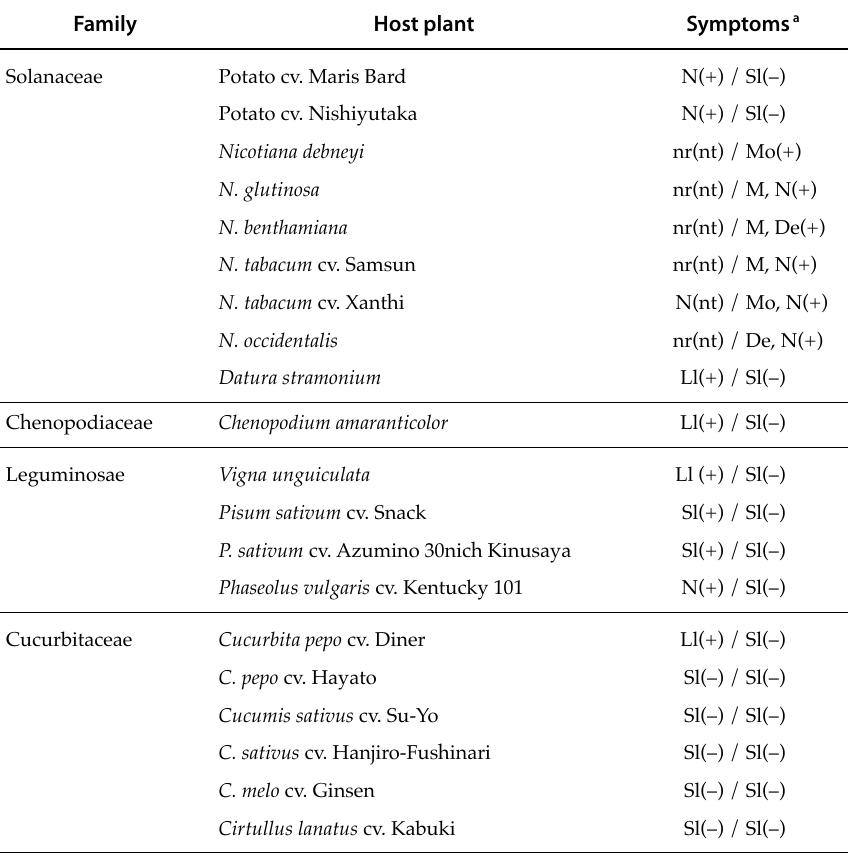
Table 2. The host range of a potato CMV isolate, PoCMV7-5 collected from Syria Family Host